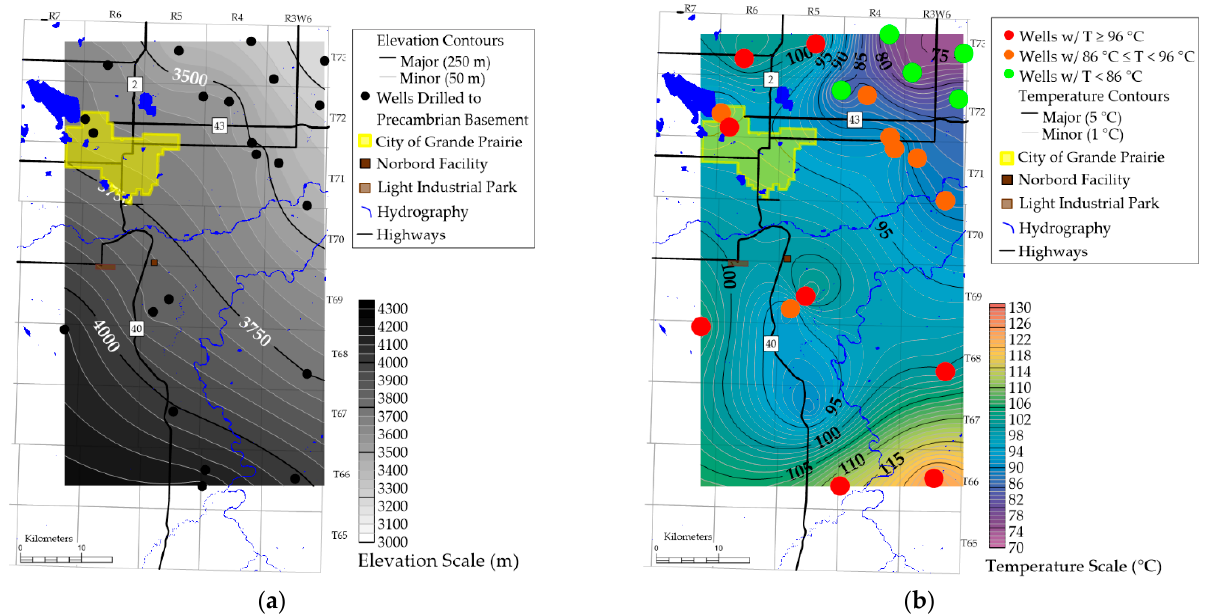
Figure 6. Contour maps of the study area for the Precambrian Basement showing ( a ) depth to the top and ( b ) temperature at the top.